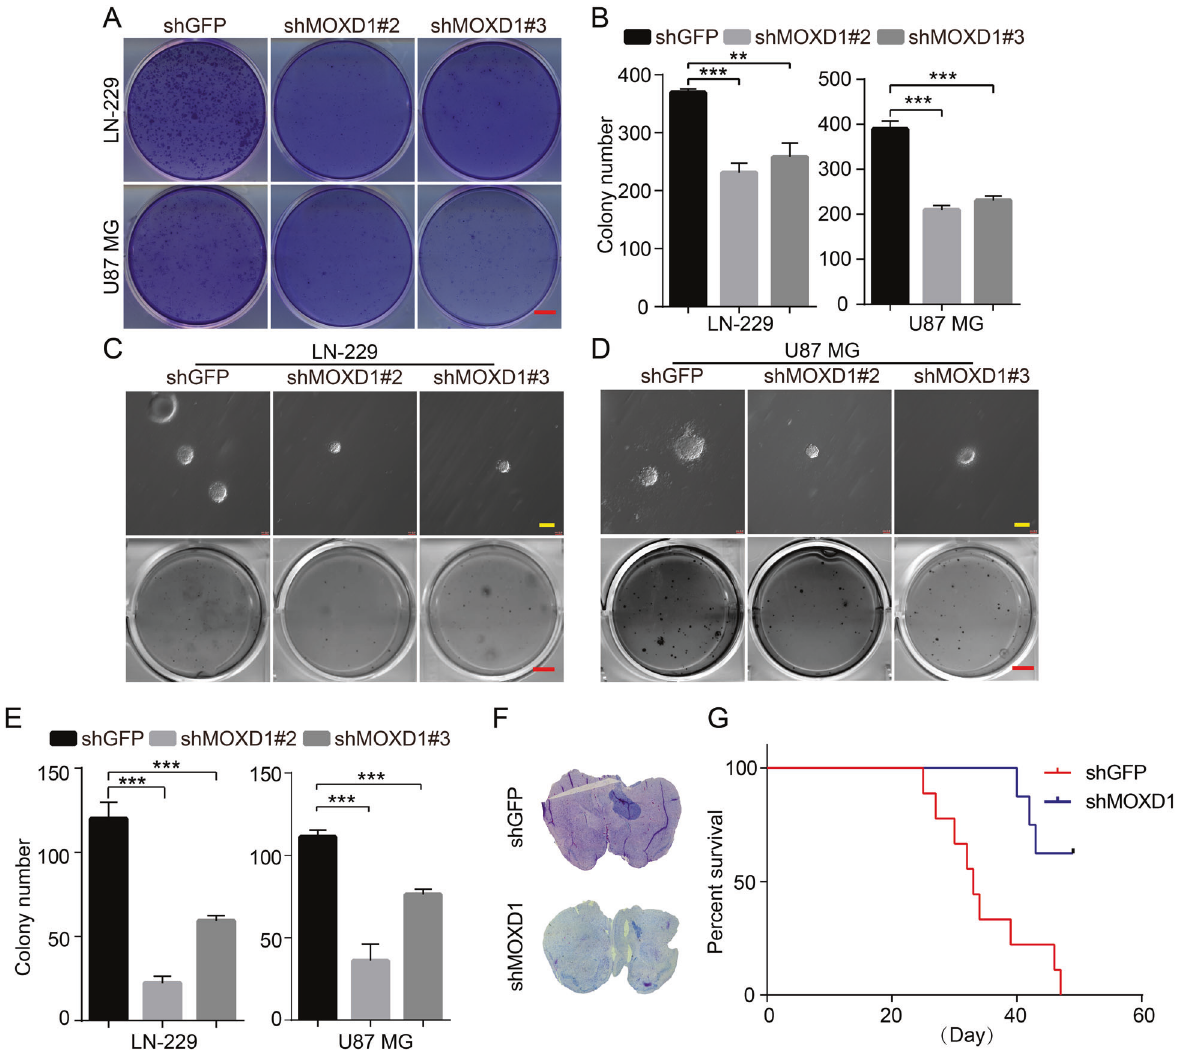
intracranially with MOXD1 knockdown